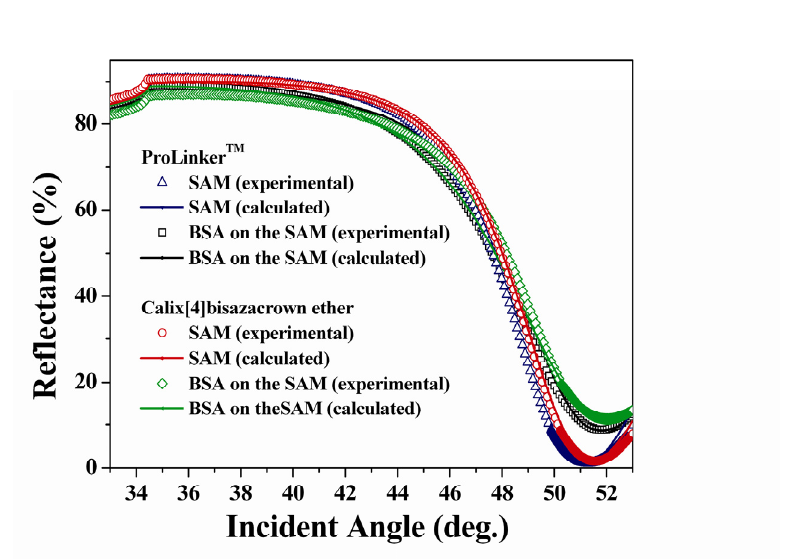
Figure 4. Experimental and simulated theoretical SPR curve corresponding to SAMs and BSA